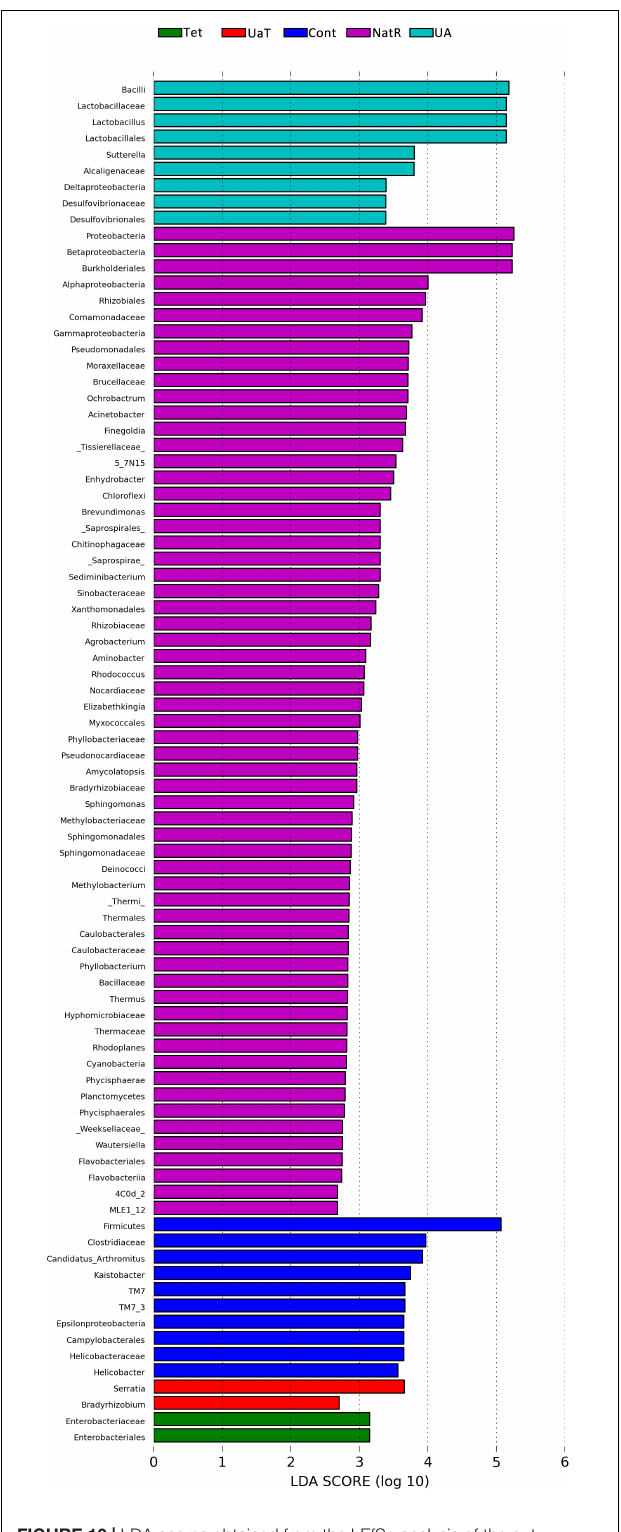
FIGURE 10 | LDA scores obtained from the LEfSe analysis of the gut microbiota in different groups. An LDA effect size of greater than 2 was used as a threshold for the LEfSe analysis. All group names correspond to those described in the legend of Figure 2